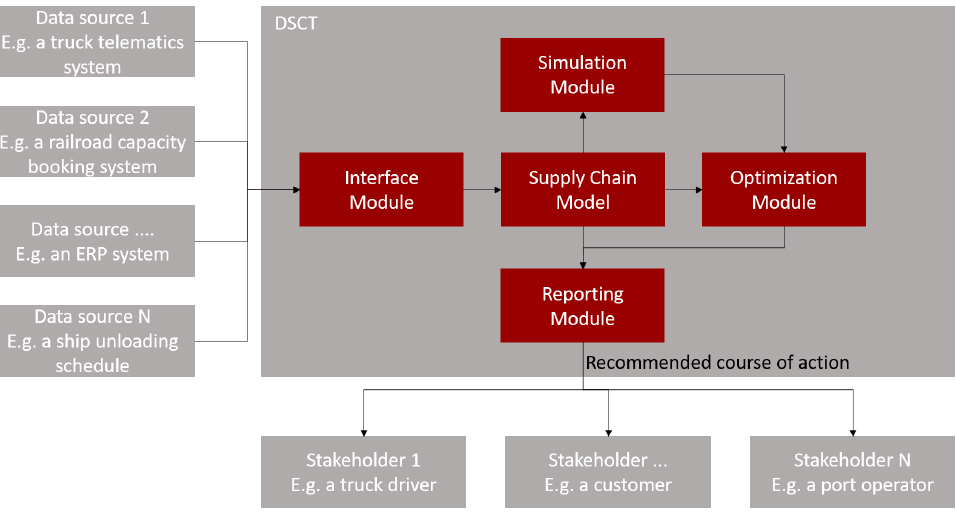
Figure 5. Proposed DSCT